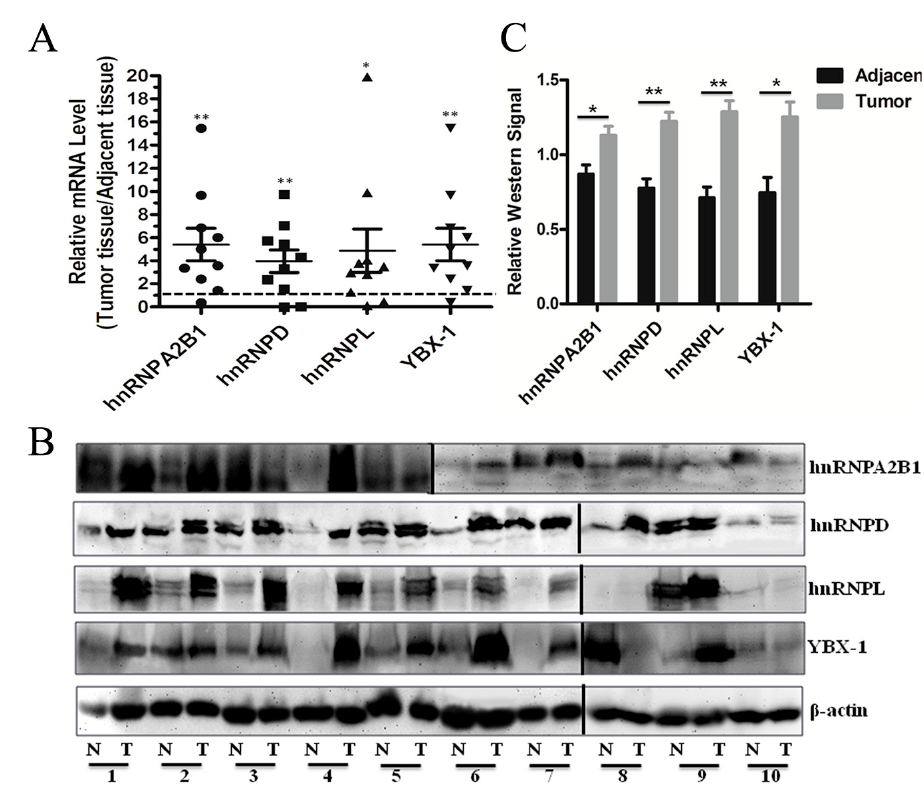
Figure 5. Expression levels of hnRNPs and YBX-1 in GC and adjacent tissues. ( A ) qRT-PCR ( n = 10) results showing the mRNA expression of hnRNPs and YBX-1. The ratio below the dotted line represented down-expression in GC tissues; otherwise represented up-expression in GC tissues; ( B ) Western blots ( n = 10) of hnRNPs and YBX-1. N represent adjacent tissue and T represent tumor tissue; ( C ) Grayscale scanning of western blots bands. The ratio was compared to β -actin and statistically analyzed. Significance of differences between GC and adjacent tissues are displayed by ** p -value < 0.01 or * p -value < 0.05.